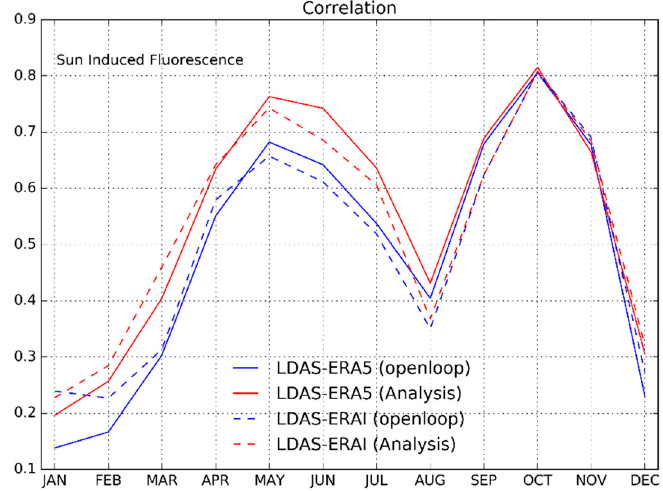
Figure 16. Seasonal correlation between GOME-2 sun-induced fluorescence and simulated GPP covering the period of 2010–2016.